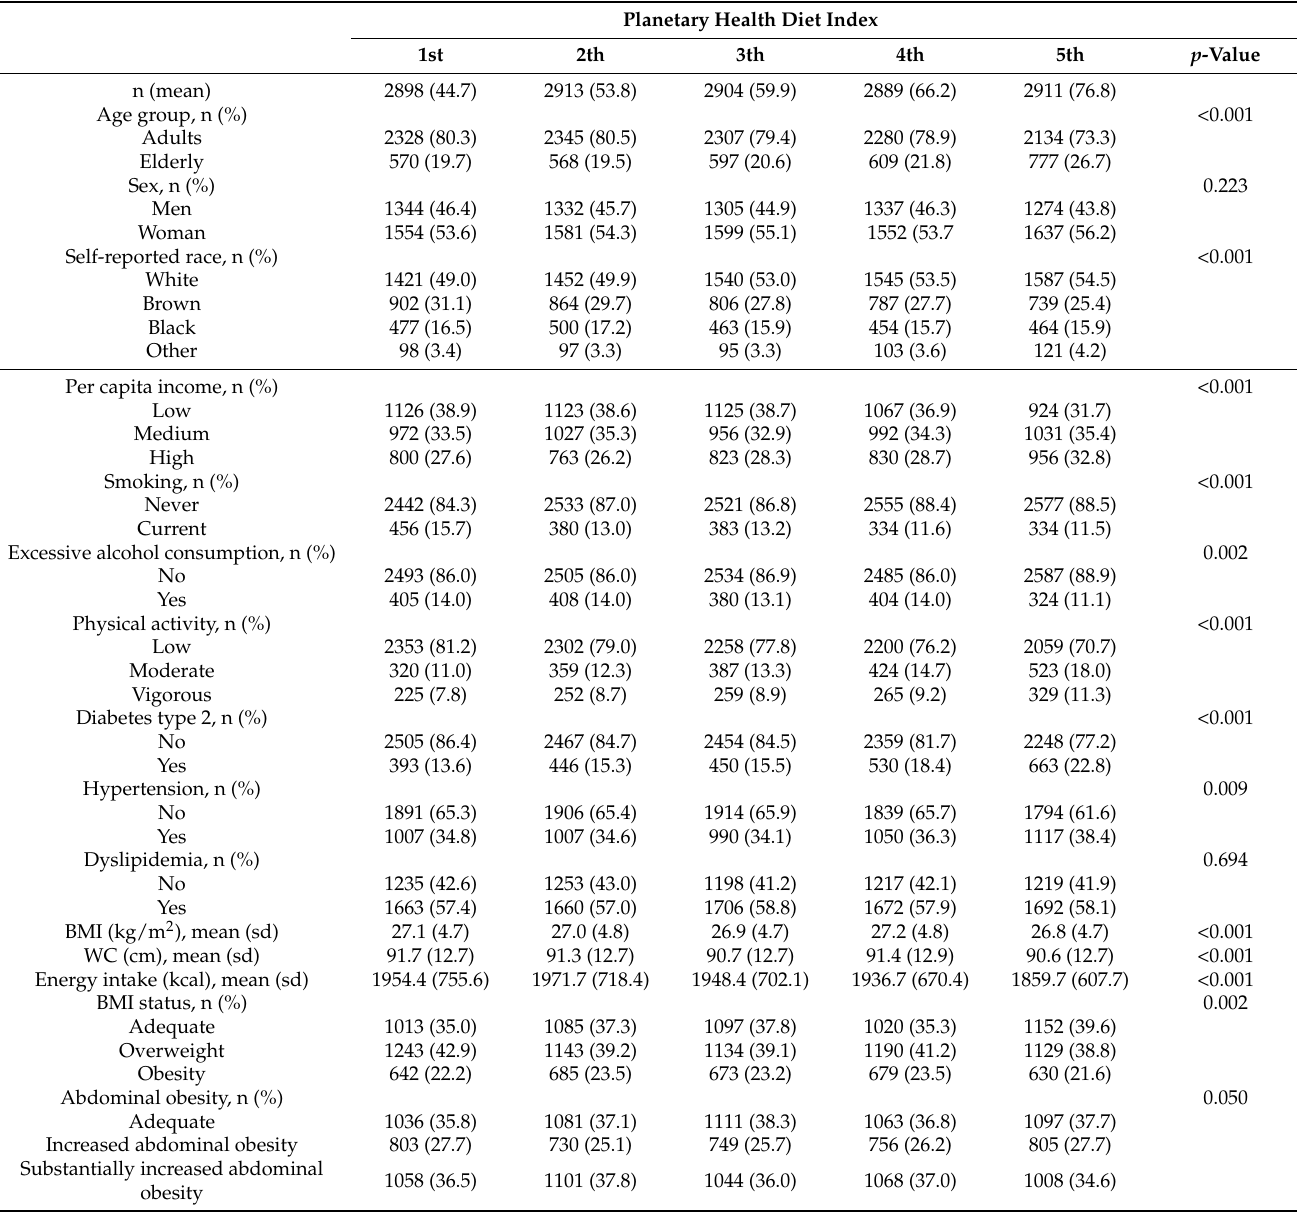
Table 1. Baseline characteristics of participants according to quintiles of the Planetary Health Diet Index. ELSA-Brasil,